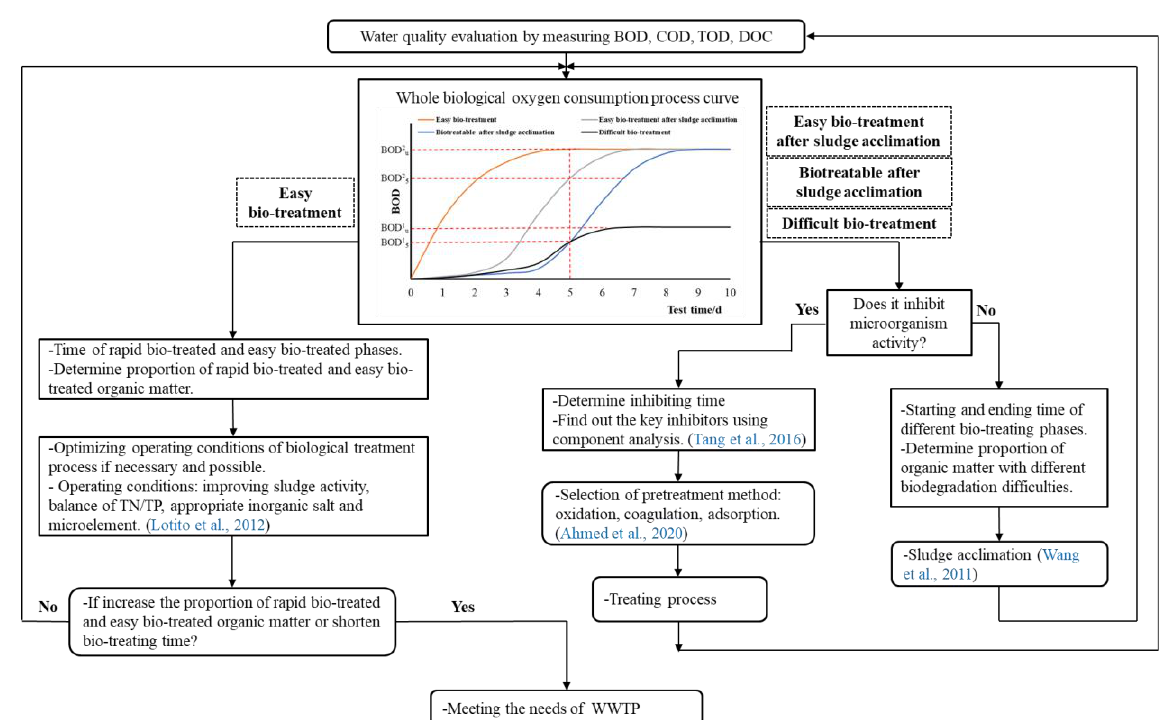
Figure 2. A complete biodegradability evaluation process of wastewater.